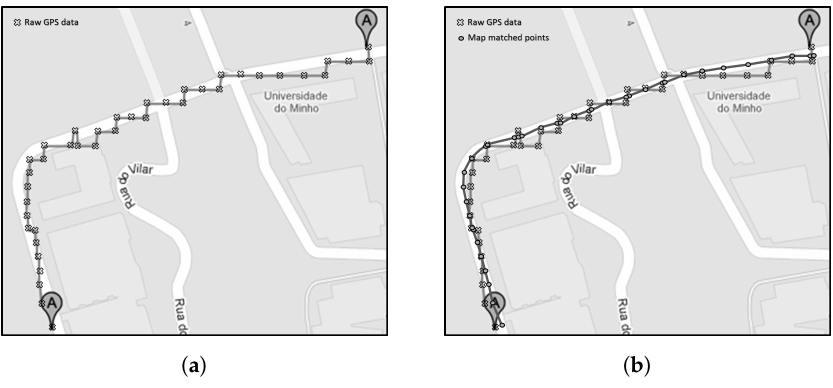
Figure 8. Trajectory data pre-processing (extracted from [41]). ( a ) Route obtained from database raw data; ( b ) Error removal from raw